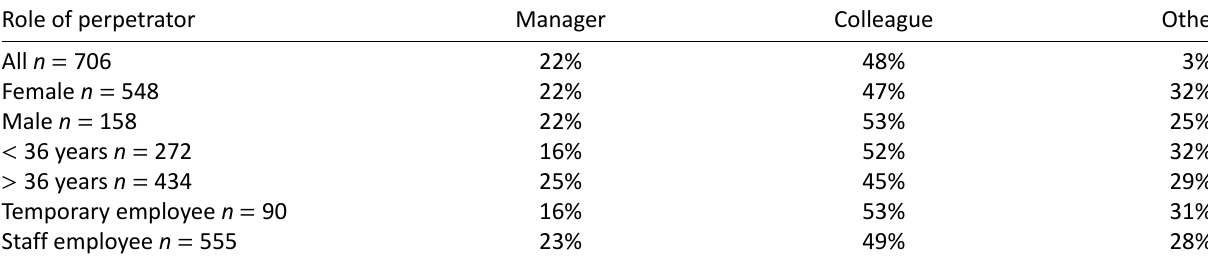
Table 5. Harassed by who (SH + UA)?